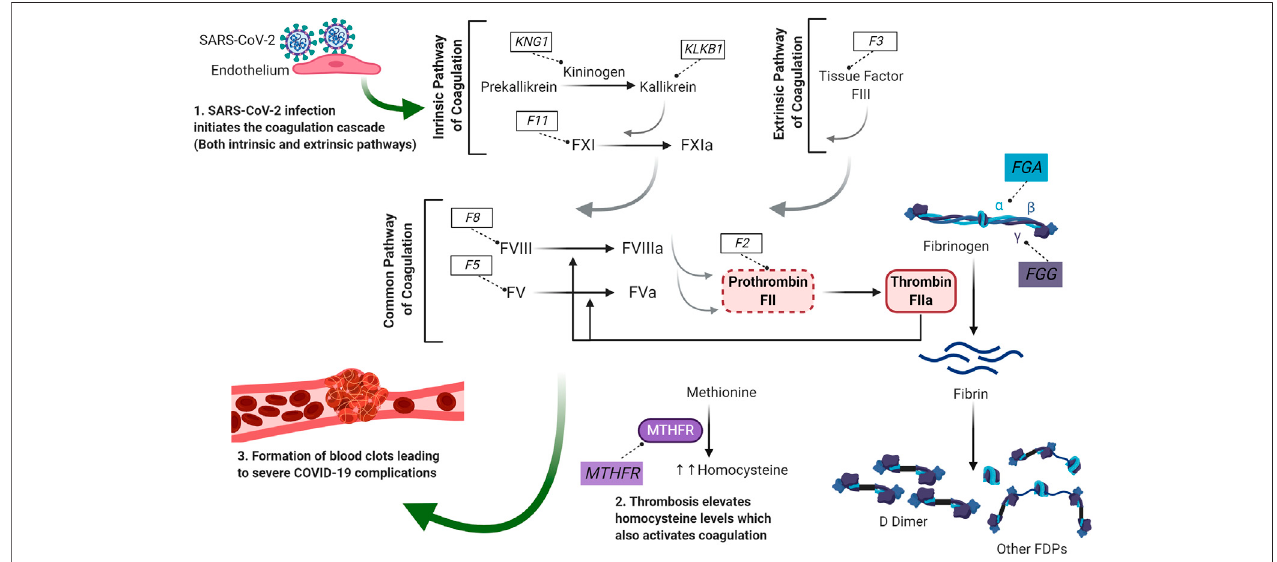
FIGURE 1 | The molecular link between key genes in coagulation during COVID-19 infection. SARS-CoV-2 infection results in an injury in the endothelium which leads to the activation of the coagulation cascade; both the intrinsic and the extrinsic pathway. Within the extrinsic pathway, tissue factor (encoded by F3) initiates the cascade to activate the common pathway of coagulation. Within the intrinsic pathway, prekallikrein is converted to kallikrein via the action of kininogen and factor XI is activated.The activation ofFactor XI initiates thecommon pathway ofcoagulationand leadsto theactivation ofseveral coagulationfactorsincluding factor VIII and factor V. Thrombin converts Fibrinogen to Fibrin. Fibrin is then broken down to D-dimer and other FDPs. This SARS-CoV-2-induced thrombosis also leads to elevated levels of homocysteine which can eventually activate the coagulation cascade. Genes of interest are presented in boxes. For purpose of clarity, this illustration is only highlighting the genes of interest that were picked by XGR analysis to associate with thrombosis. Grey arrows indicate activation of other coagulation factors. F: CoagulationFactor,Fa:activatedcoagulationfactor.FDPs:Fibrindegradationproducts,FGA:Fibrinogenalphachain,FGG:Fibrinogengammachain,KLKB1:kallikrein, KNG1: Kininogen 1, MTHFR: methylenetetrahydrofolate reductase.